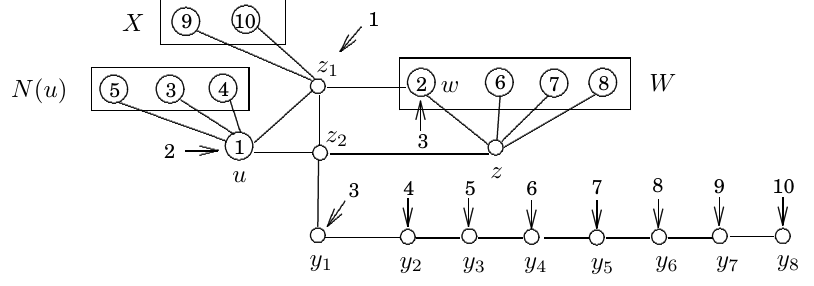
Figure 6: The graph G in the proof of Theorem